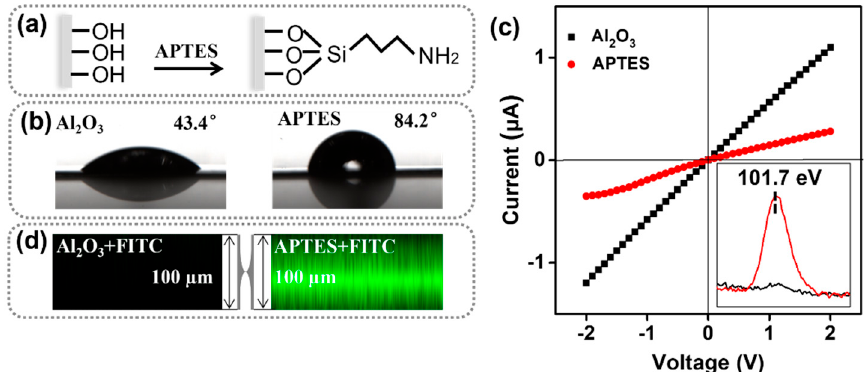
Figure 1. ( a ) Schematic diagram of the modification of alumina nanochannels with APTES. The characteristic for successful modification of APTES by ( b ) CA measurement, ( c ) I-V curve (the inset is XPS spectrum in the Si2p core level region), and ( d ) laser scanning confocal microscope (LSCM) imaging. The diagram in the middle shows the cross-section of a typical single channel in the alumina membrane.